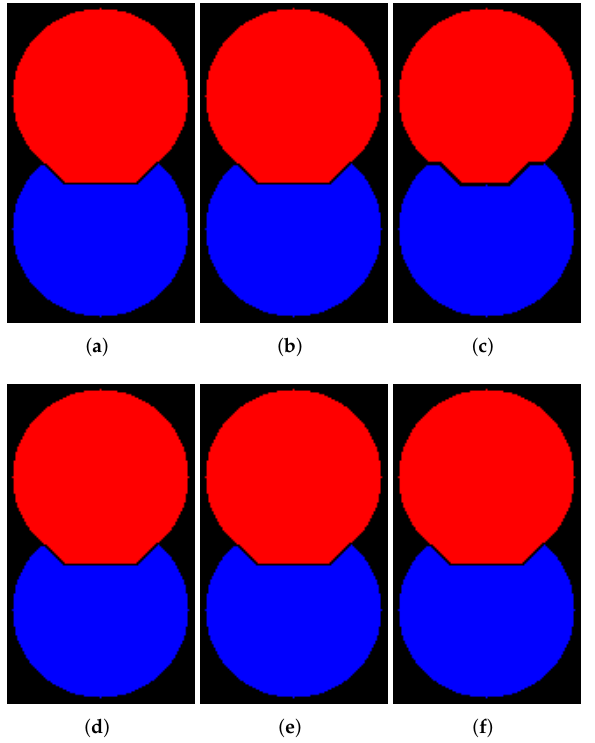
Figure 8. Results of segmentation via watershed with WL (8-connectivity): ( a ) ImageJ; ( b ) ITK;